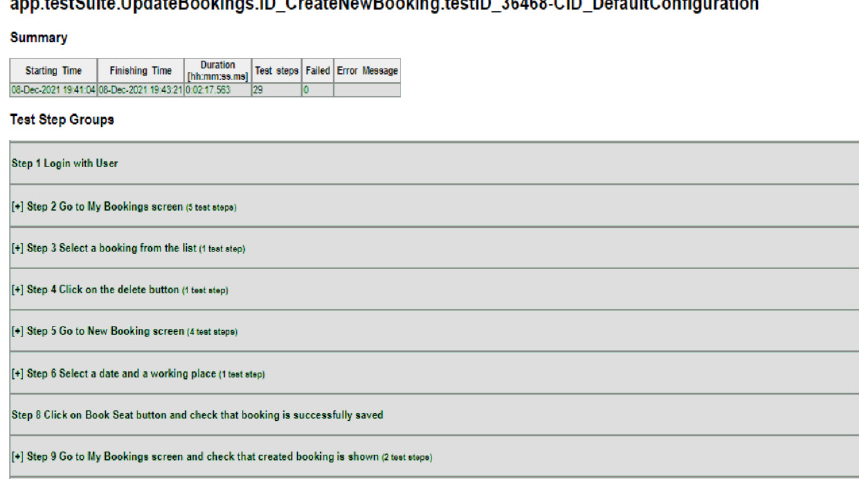
Fig. 7. Report of the test